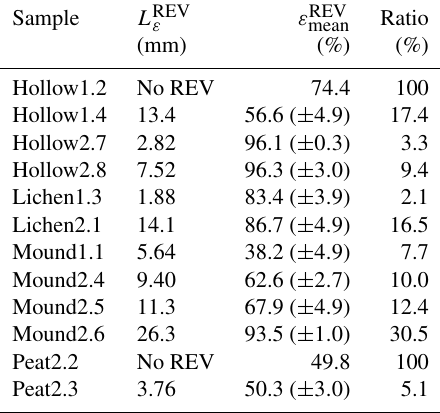
Table 4. Obtained representative elementary volume based on porosity (REV ε ). L REV ε is the side length of a cubic REV of poros- ity. ε REV mean is the average porosity of a given cubic REV. The ratio represents the volumetric percentage of the sample included in the